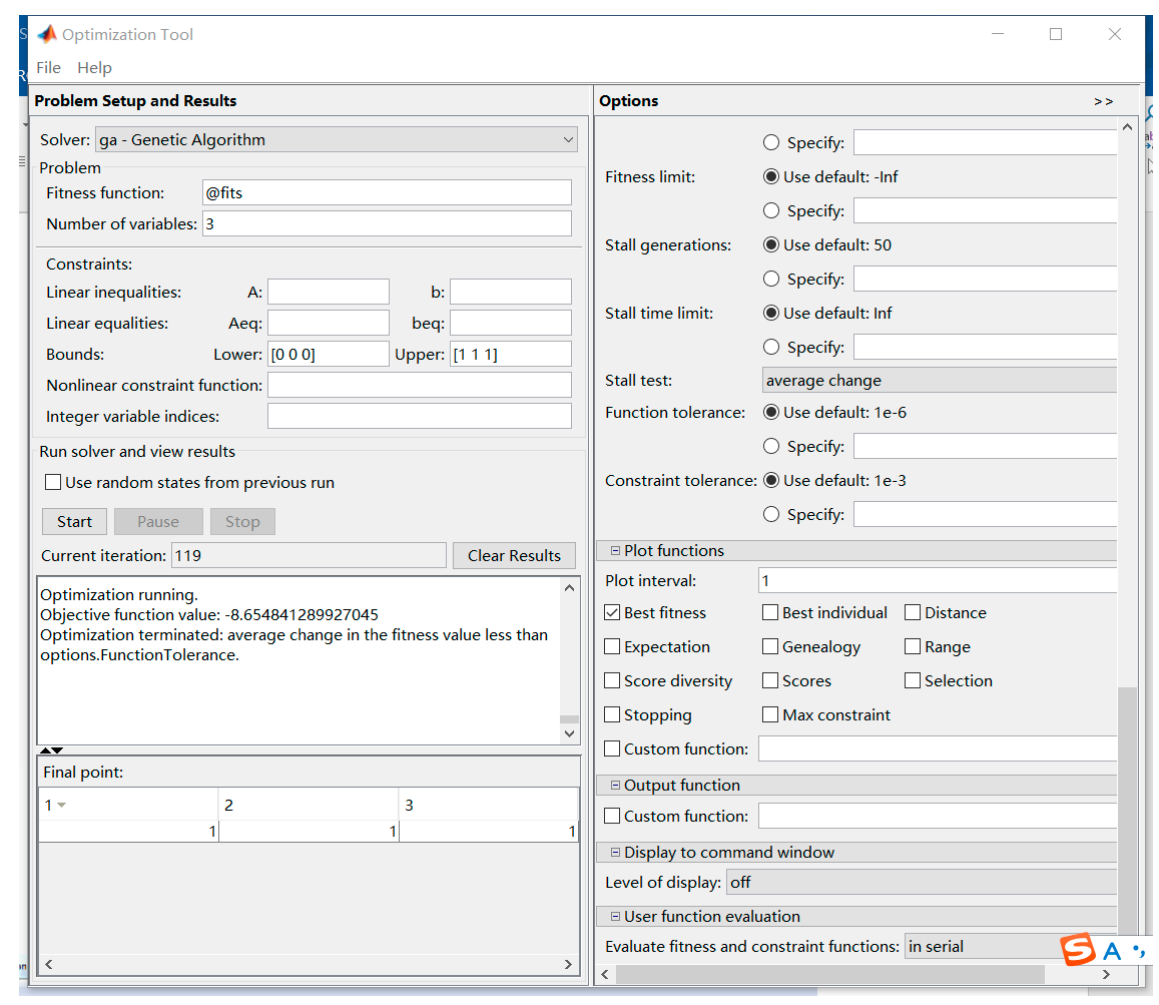
Figure 4: Model simulation